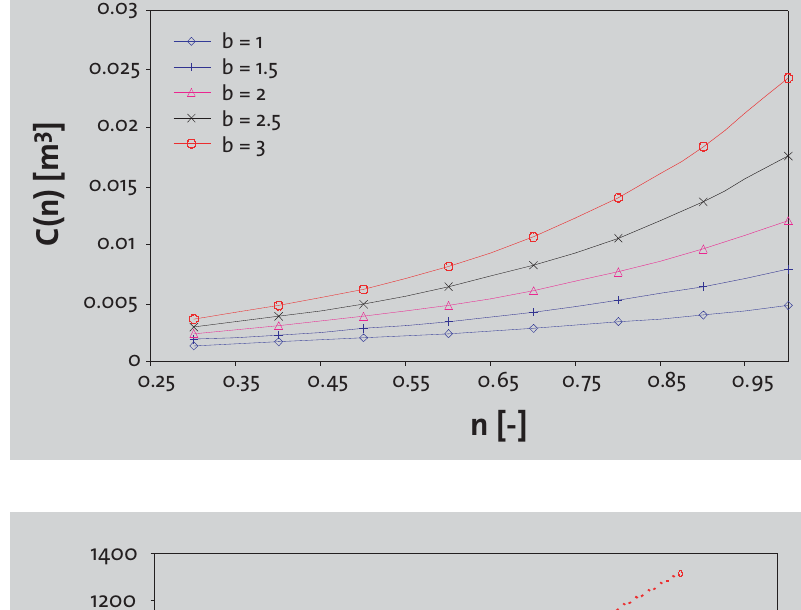
Figure 6 (above): Variation of C(n) with n and b (Ika kneader, a =0.84). Figure 7 (middle): Compari- son of Ika mixer ( a = 0.84) and rheometer data for N01. Figure 8 (below): Compari- son of kneader (dashed lines, a = 0.84) with rheo- meter (solid lines) data for